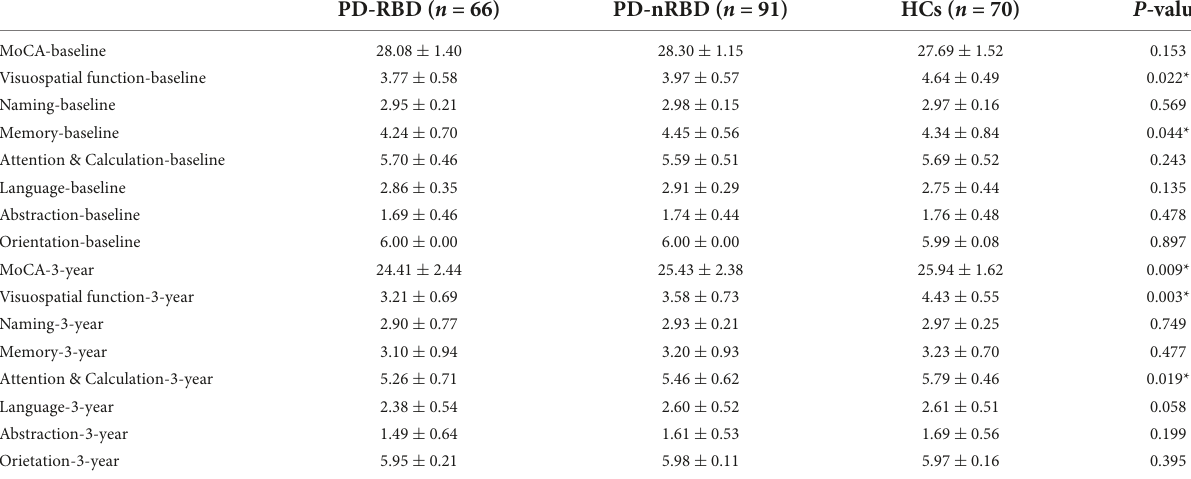
TABLE 2 MoCA scores at baseline and at the end of the 3-year